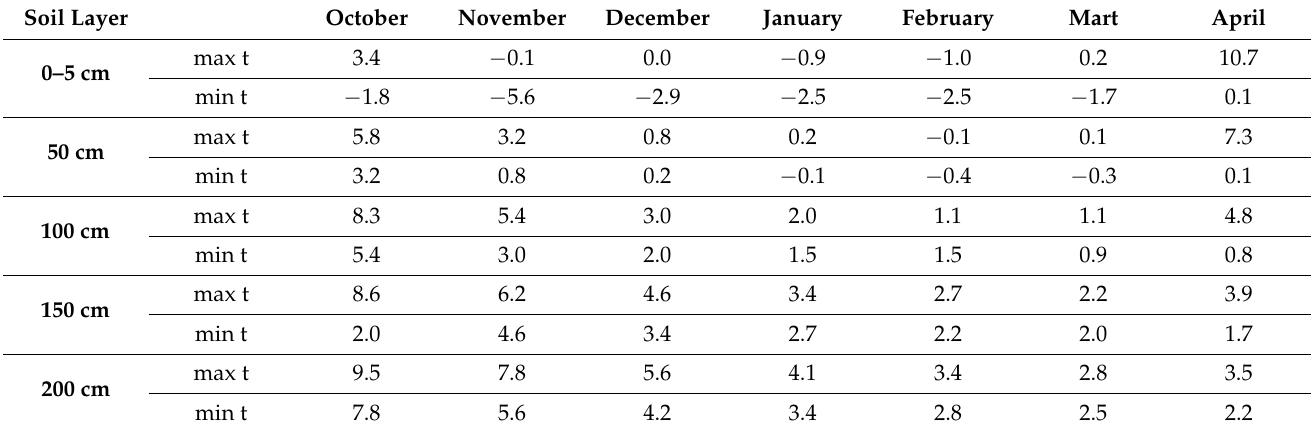
Table 1. Soil temperature at different depths of mesocosms during the winter